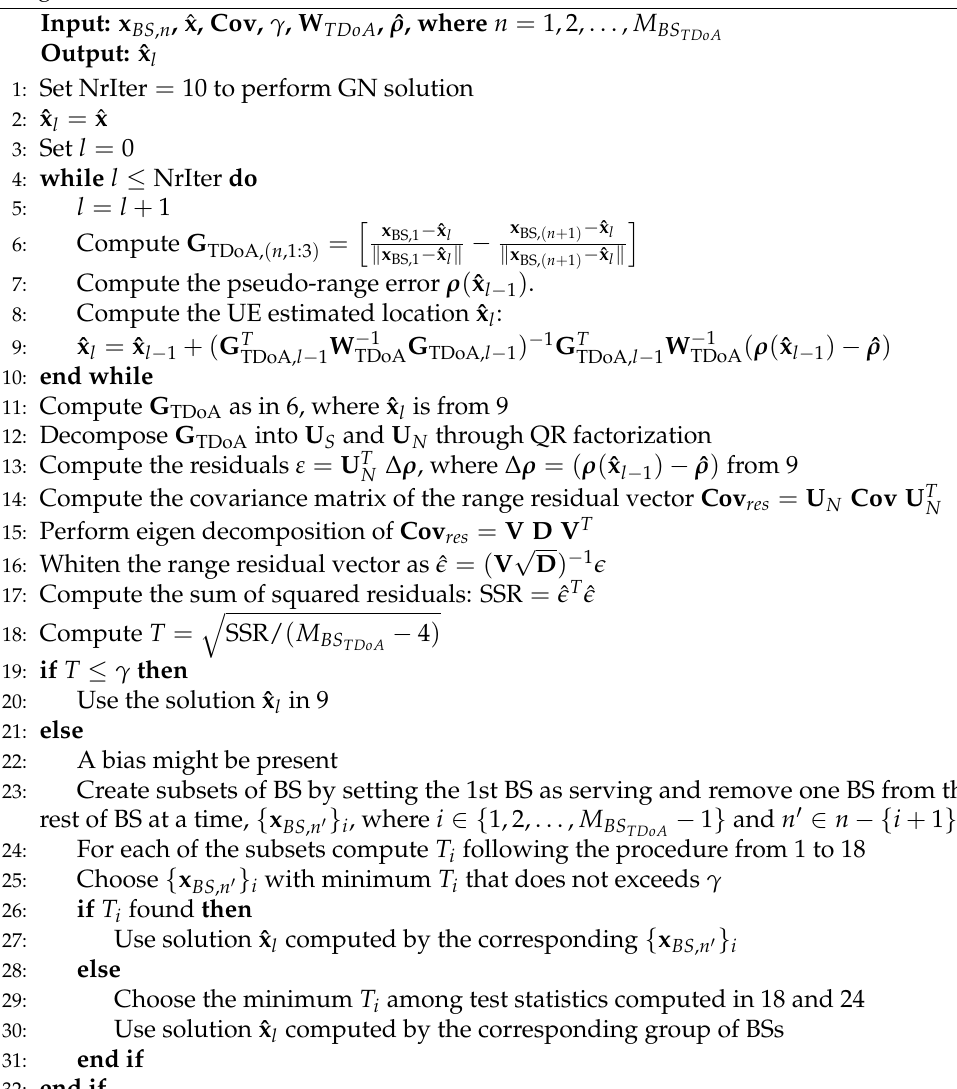
Algorithm 1 NLoS BS detection and exclusion. Procedure from 1 to 20 performs the algorithm with all the available BS, while procedure from 22 to 27 performs the algorithm excluding one BS at a time when the computed test statistic with all the available BS exceeds the given